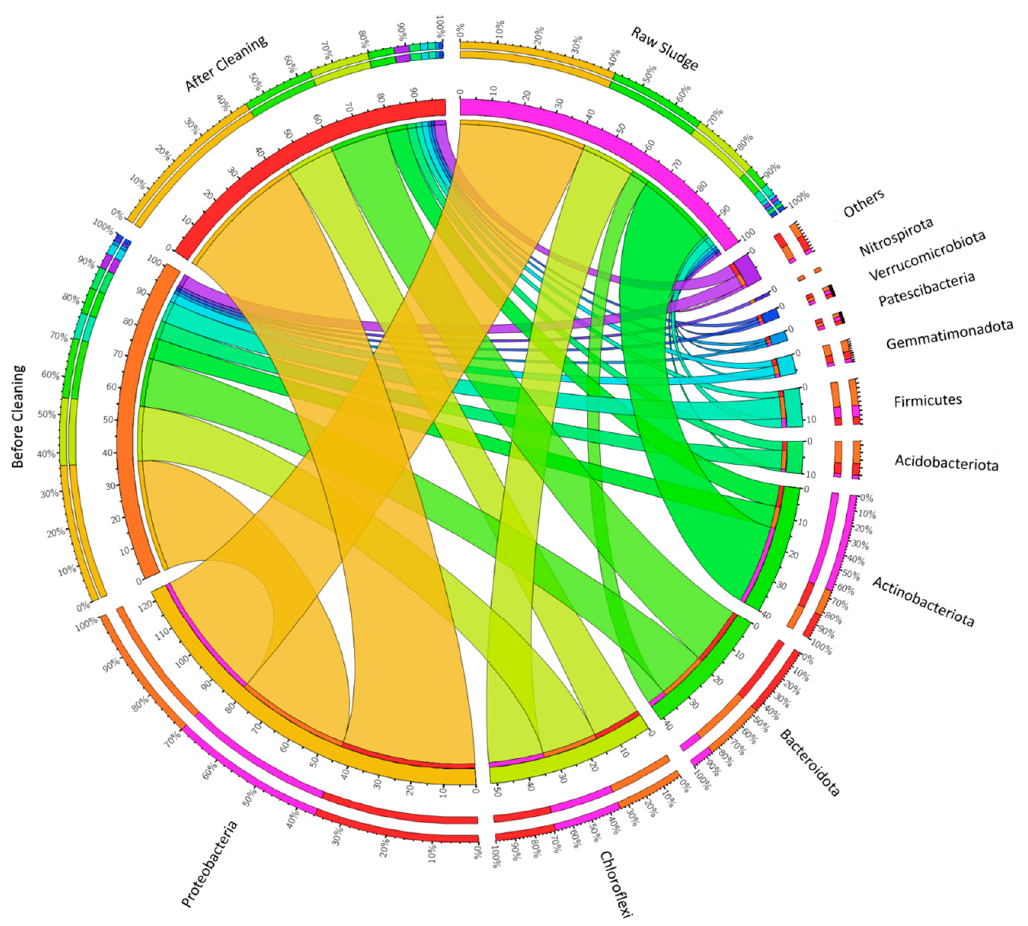
Figure 6. Microbial community profiles of three biofilm samples at phylum level. The coordinate scale refers to the relative abundance of the microbial distribution in the samples (%).